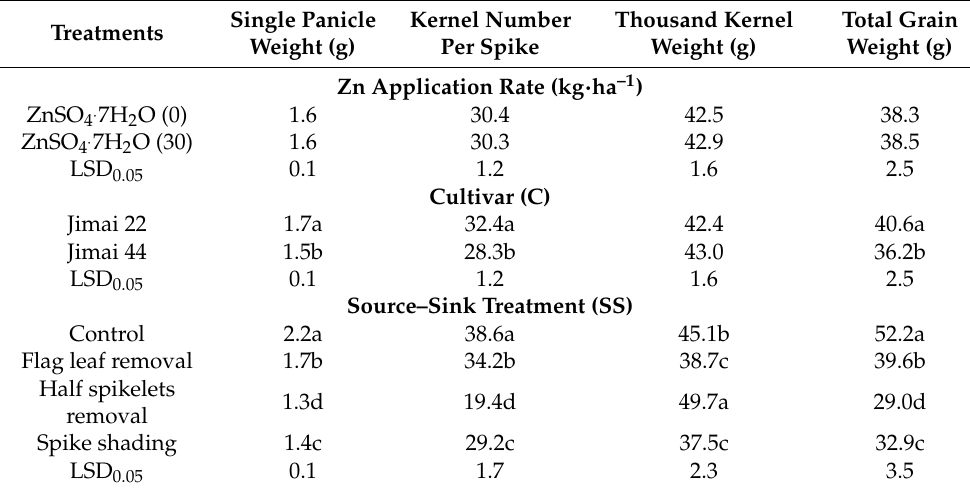
Table 1. Effects of soil Zn application and source–sink manipulations on grain yields and yield components of different wheat